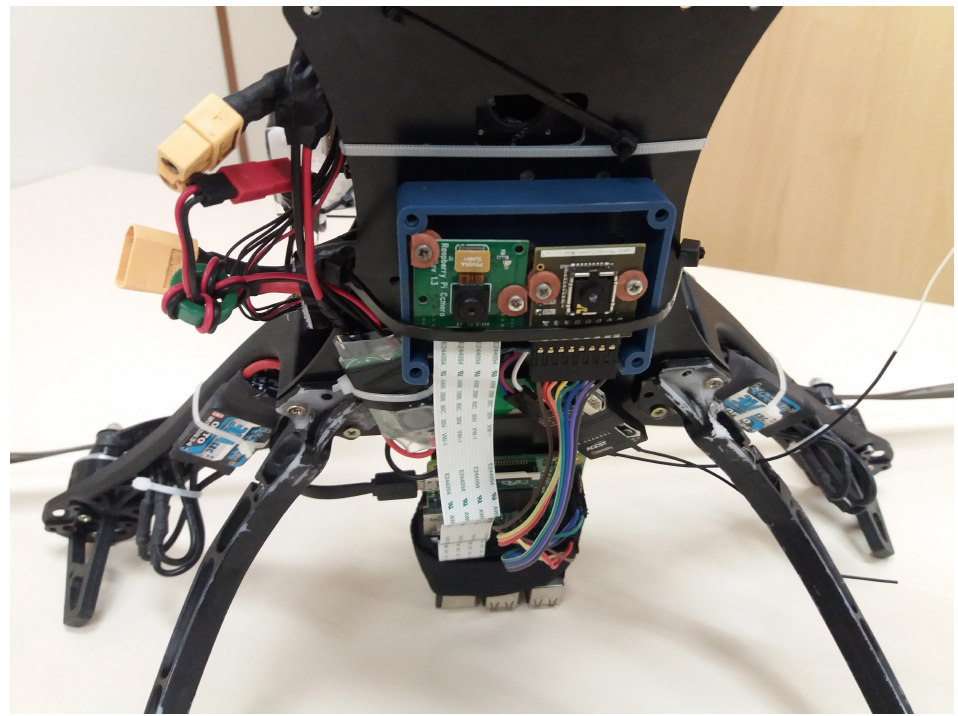
Figure 6. Quad-rotor platform used to collect images for PRS